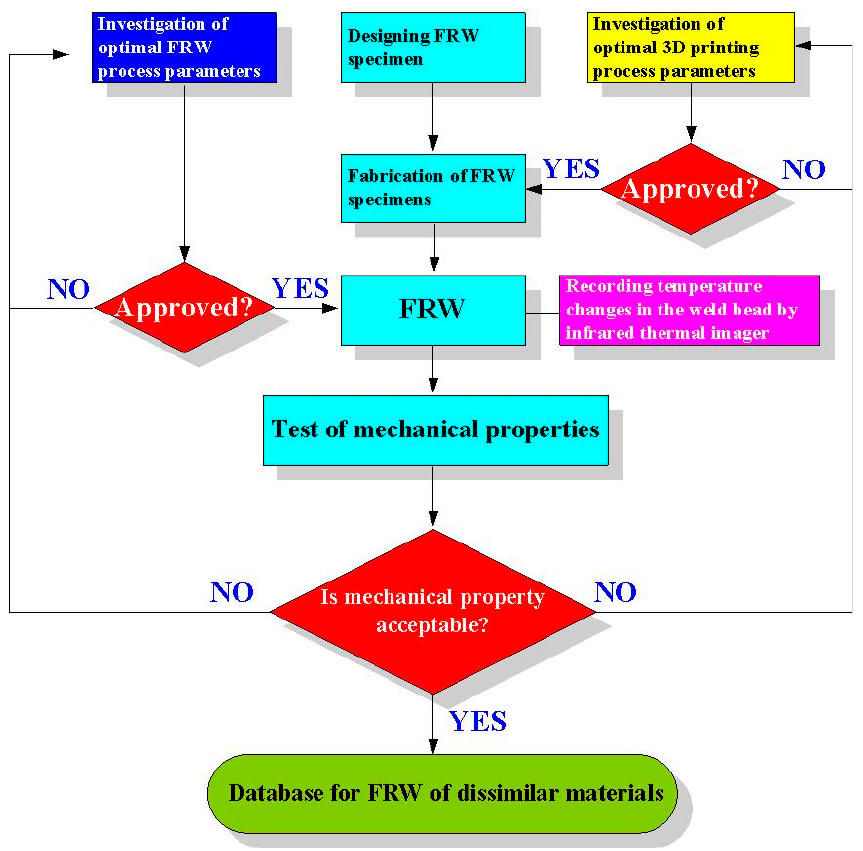
Figure 1. Flow diagram of the experimental methodology.